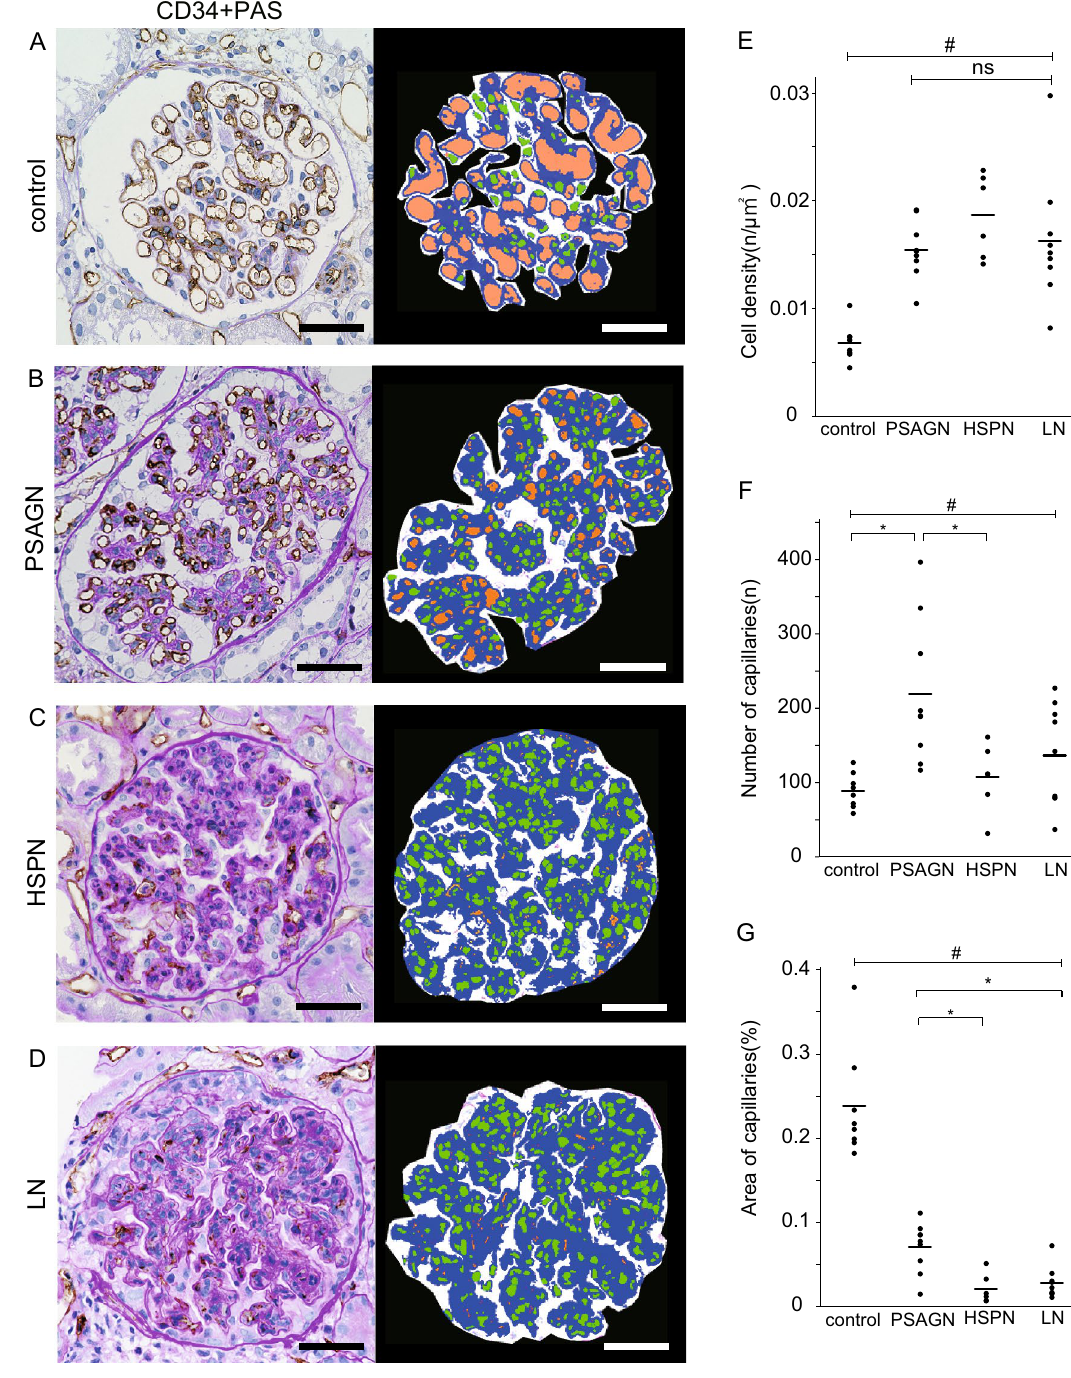
Figure 4. Association between disease activity and glomerular endothelial cell injury in GN with EP lesions. Representative images of control ( A ), PSAGN ( B ), HSPN ( C ), and LN ( D ) samples. The left panels of ( A , B , C , D ) show CD34 immunostaining with PAS counterstain, and right panels show images from the computer-assisted image analysis of same glomeruli. The nuclei and capillary lumen are shown in green and orange, respectively. The total glomerular tuft area is the sum of the orange, green, and blue parts. Graphs show the cell density ( E ), number of capillaries ( F ), and percentage of capillary lumen area per total glomerular tuft area ( G ). Scale bars, 50 μm. # p < 0.05 among the four diseases by Kruskal–Wallis test, * p < 0.05 between each group by Steel–Dwass test, ns, no